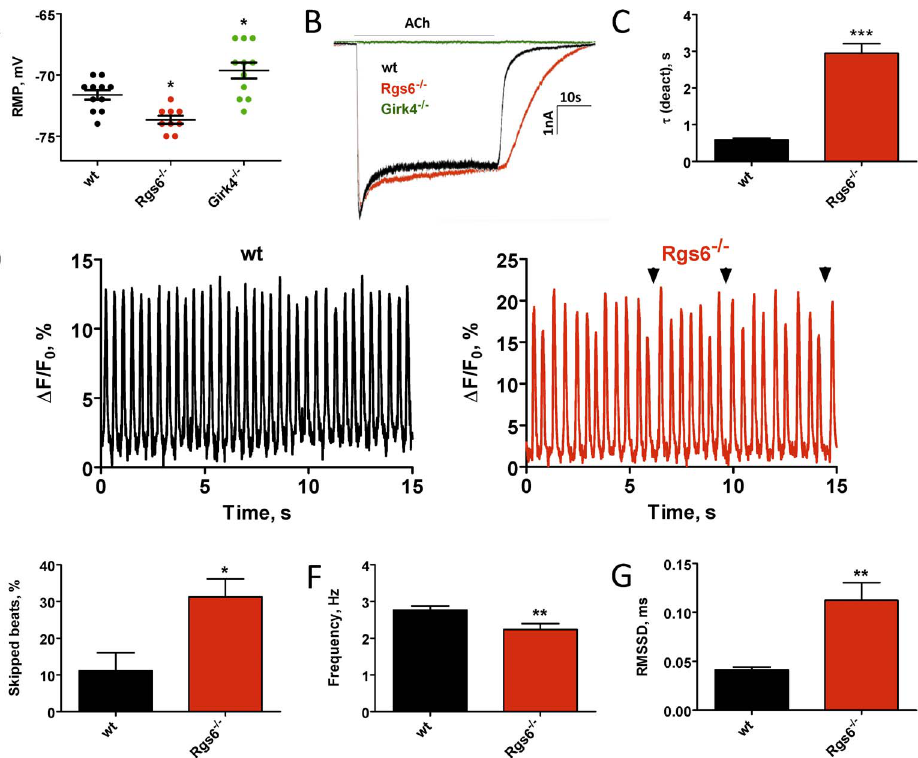
Figure 3. Ablation of Rgs6 reduces excitability of sinoatrial cells and disrupts their automaticity. A, Resting membrane potential measured immediately after obtaining whole-cell access in wild-type (wt), Rgs6 2 / 2 , and Girk4 2 / 2 SAN cells. B, Inward currents evoked by application of acetylcholine (ACh, 100 m M) in SAN cells from wild-type (black), Rgs6 2 / 2 (red) and Girk4 2 / 2 (green, no current) mice. C, Summary of steady-state ACh-induced deactivation kinetics of I KACh in wild-type and Rgs6 2 / 2 SAN cells (n=11–15 cells/genotype). D, Representative traces of spontaneous calcium oscillations recorded from wild-type (black; n=14) and Rgs6 2 / 2 (red, n=20) SAN cells. Arrows show skipped beats. E, Quantification of SAN arrhythmic events defined as more than 15% change in duration of peak-to-peak interval of spontaneous calcium oscillations in wild-type (n=11) and Rgs6 2 / 2 (n=17) SAN cells. F, Reduced frequency of spontaneous calcium oscillations recorded in Rgs6 2 / 2 SAN cardiomyocytes as compared to wild-type (n=14–20 cells/genotype). G, Increased variability of spontaneous calcium oscillations in Rgs6 2 / 2 SAN cells as determined by increase in RMSSD values (n=14–20 cells per genotype). Symbols: *P , 0.05; **P , 0.01; ***P ,